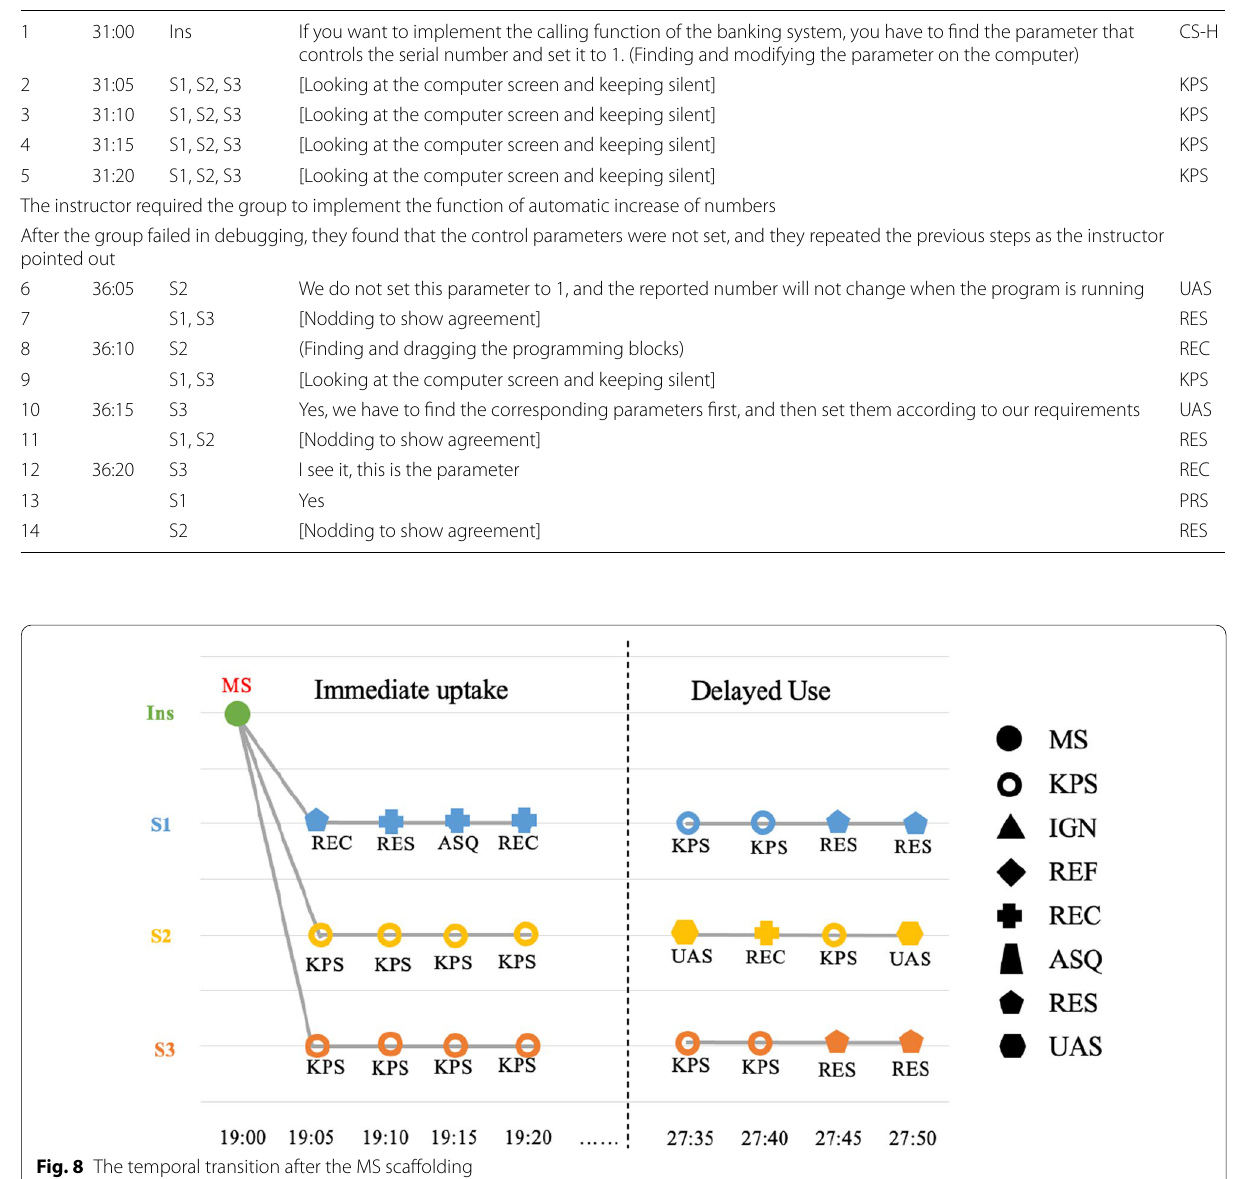
Table 5: line 3, 5, 7, 9, 11, 12, 14, 16).